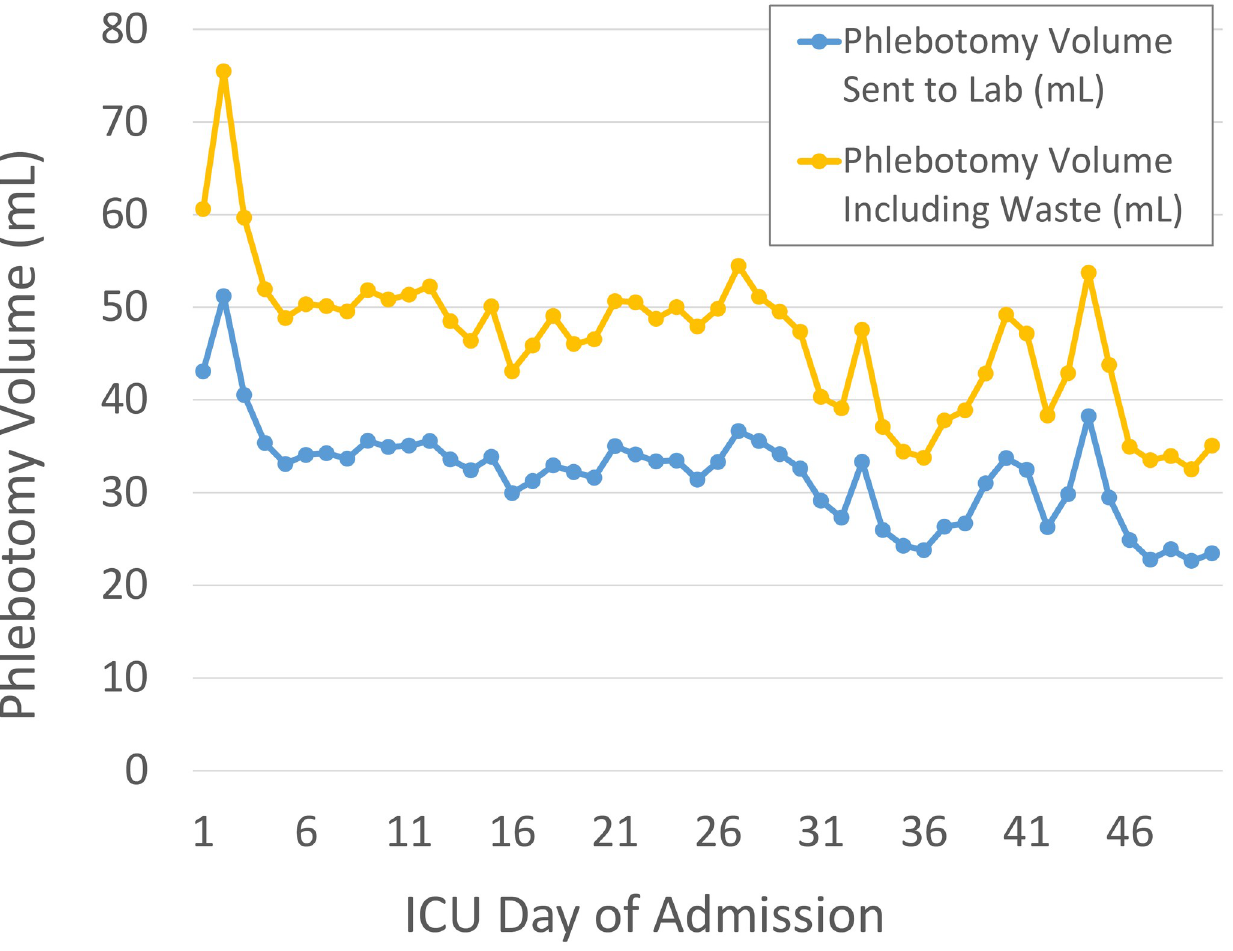
Fig 1. Phlebotomy volume by date from ICU admission with and without the estimates for waste during vascular access. N = 428.